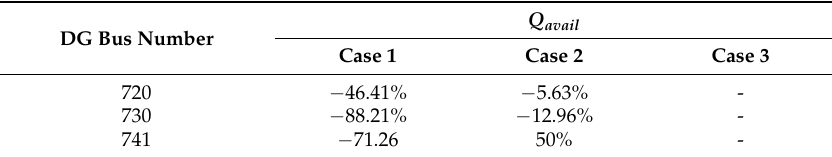
Table 3. Optimal Q avail for each case.